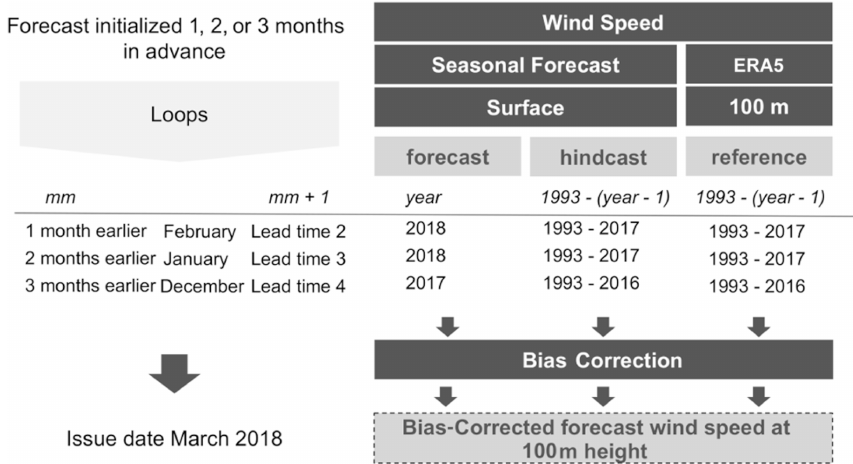
Figure 7. Scheme of the methodology applied. Gray boxes indicate the data, methods, and results. The required parameters to analyze the March 2018 event are specified for the simulations initialized 1, 2, and 3 month(s) in advance on a white